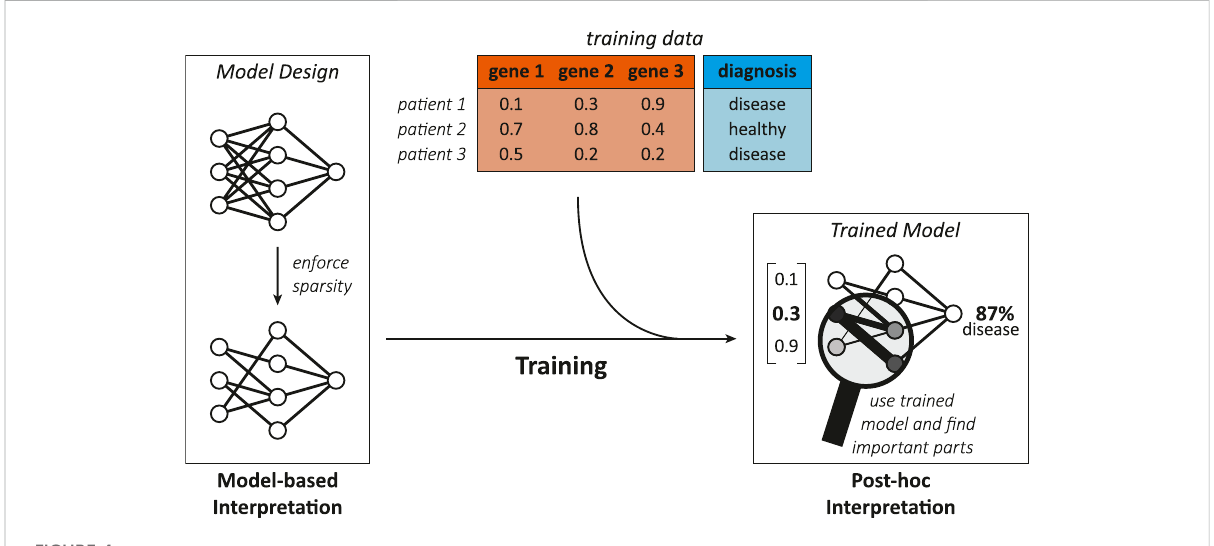
FIGURE 4 Illustration showing the difference between model-based and post-hoc interpretation methods. A model-based interpretation strategy could be to design a sparse model by limiting the possible connections in a neural network (e.g., with knowledge about biological networks). Once the ML model is trained, post-hoc analysis can reveal the model parts that are most important for predictions, hinting on genes or biological interactions relevant for the